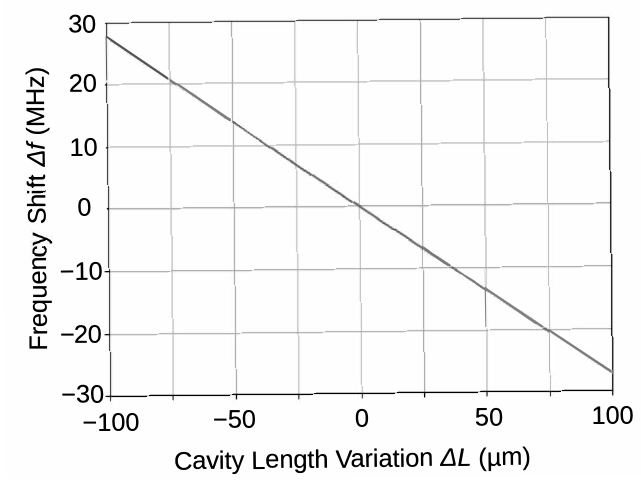
Figure 5. Frequency shift as a function of the cavity length variation calculated from the Equation (2).